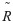
Comparisons on the overall average capacity when disk size of collaborating nodes R˜ is varied.